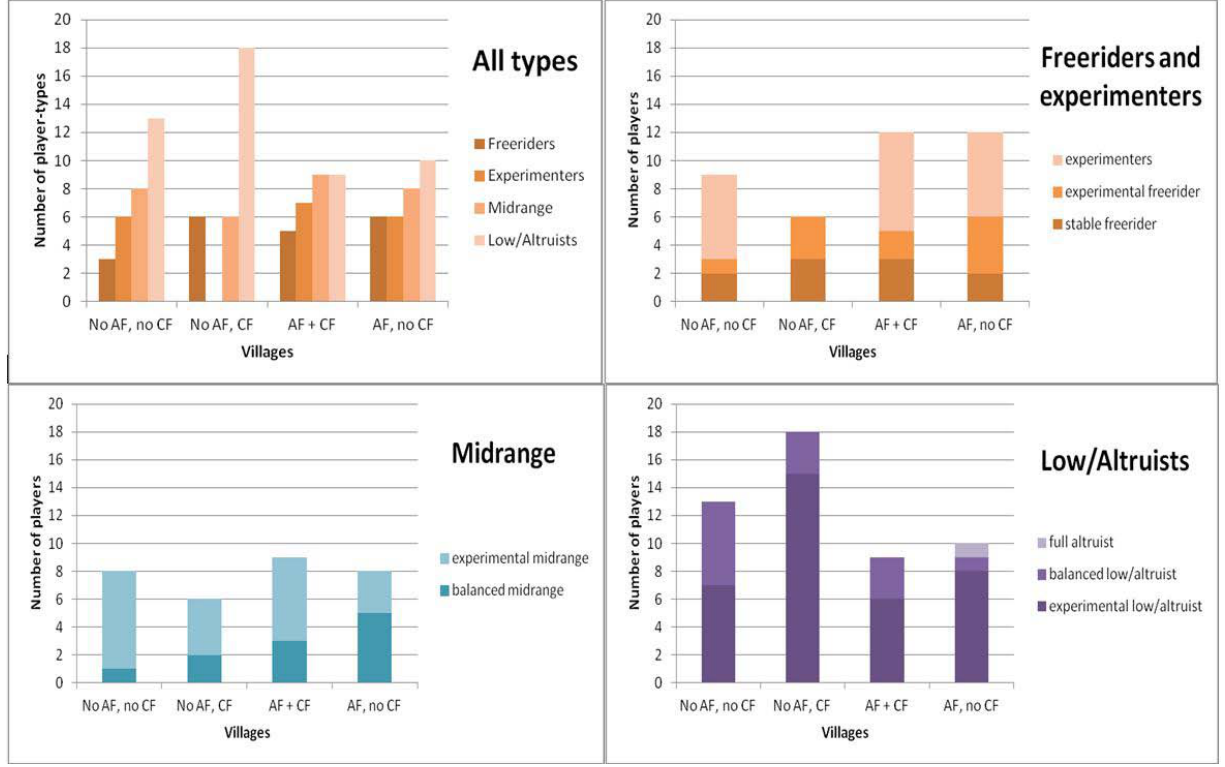
Figure 5. Classified and clustered player types and single groups of player types per